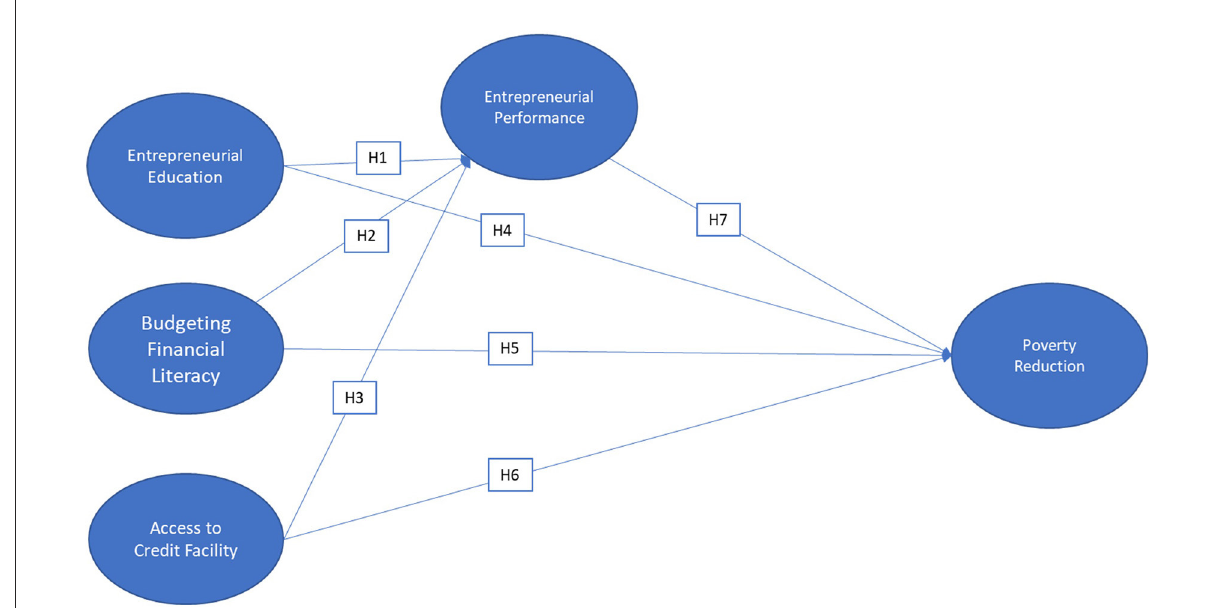
FIGURE1 Model for entrepreneurial activities in relation to poverty reduction (adopted from Maziriri and Chivandi,